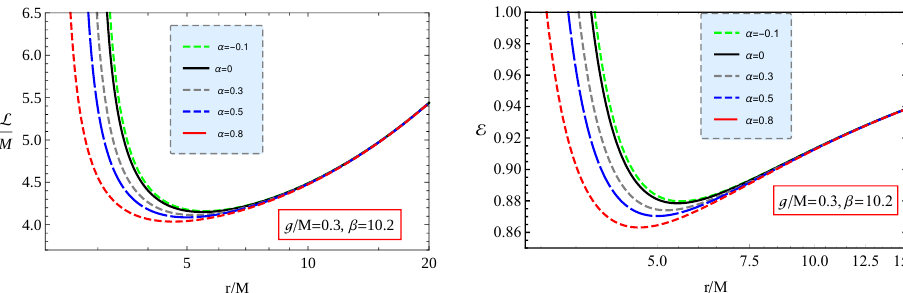
Figure 6. Radial dependence of specific angular momentum ( left panel) and energy ( right panel) of a magnetized test particle, with β = 10.2, along circular orbits for different values of the NED charge of the BH and coupling constant α .